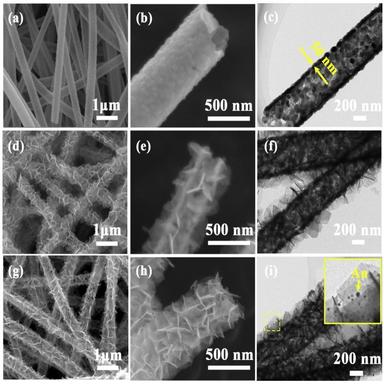
(a–c) SEM and TEM images of pure ZnO hollow nanomeshes obtained by combining electrospinning and ALD method; (d–f) SEM and TEM images of ZnO/ ZnFe2O4 composites; (g–i) SEM and TEM images of ZnO/ZnFe2O4/Au ternary heterostructure.